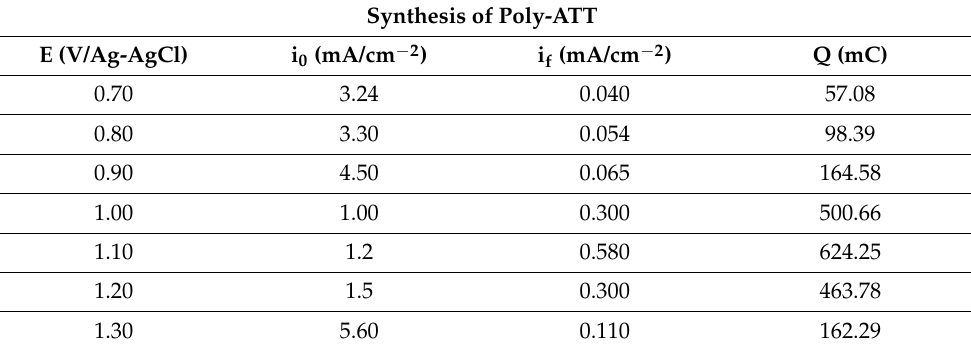
Table 1. Values of the applied potentials and the initial and final current densities recorded respectively at (t 0 = 0.1 s) and (t f = 1800 s) during the synthesis of poly-ATT on brass alloy in a methanolic solution 0.1 M KOH + 0.1 M ATT.